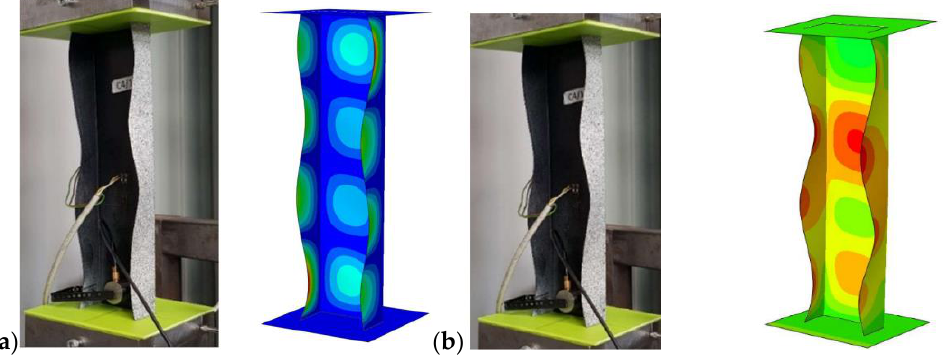
Figure 3. ( a ) Form of buckling, ( b ) form of postcritical deformation.